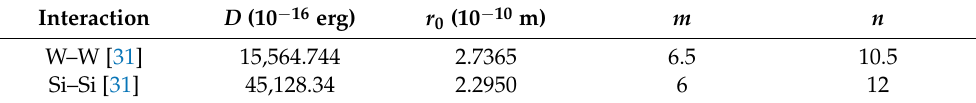
Table 1. Mie–Lennard-Jones potential’s parameters for the interactions W–W and Si–Si. Interaction